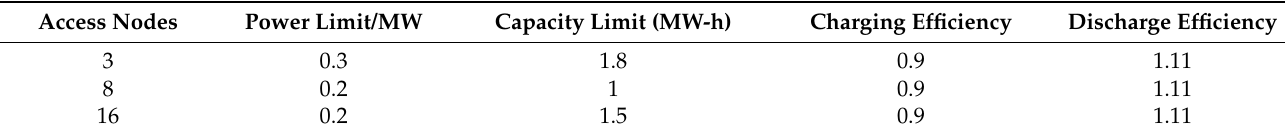
Table 3. CB parameters.